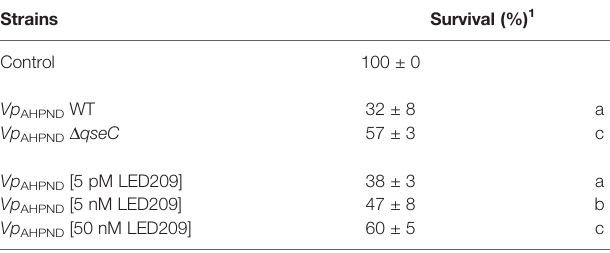
TABLE 5 | The impacts of qseC deletion and LED209 on the virulence of Vp AHPND towards gnotobiotic brine shrimp larvae ( Artemia franciscana